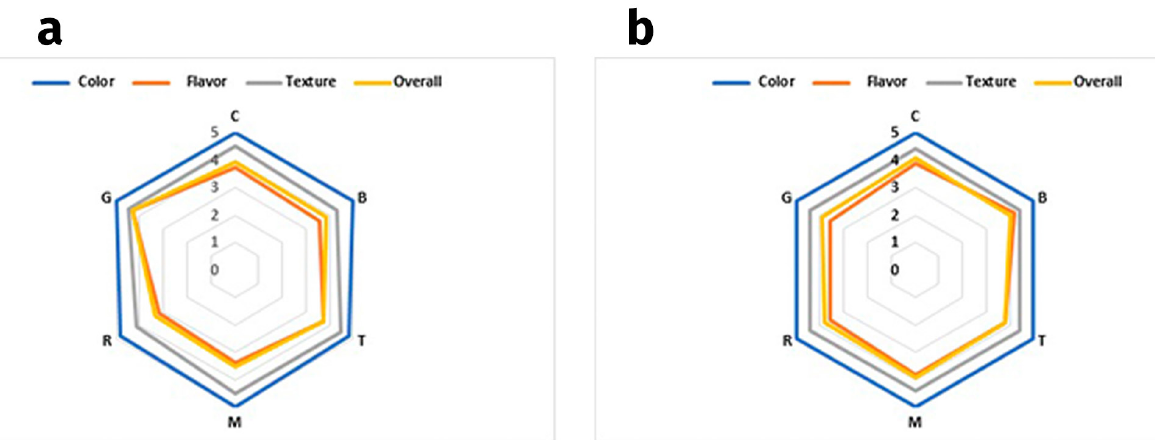
Figure 3. a. Sensorial properties of yogurt samples on the 1 st day of storage period; b. Sensorial properties of yogurt samples on the 14 th day of storage period; C: Control sample (not containing medicinal and aromatic plant); B: Basil added yogurt; T: Thyme added yogurt; M: Mint added yogurt; R: Rosemary added yogurt; G: Garlic added